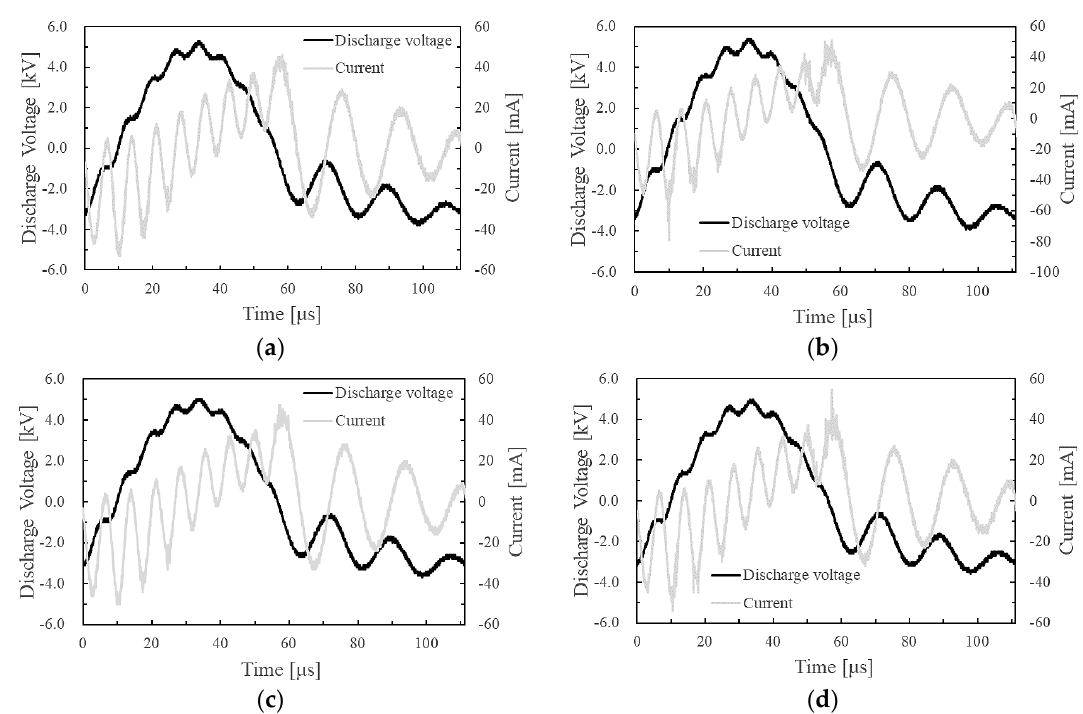
Figure 3. Discharge voltage and current waveforms at a self-sustaining discharge voltage V pp of 9.4 and 8.5 kV: ( a ) Ar / CF 4 gas mixture at V pp = 9.4 kV; ( b ) He / CF 4 gas mixture at V pp = 9.4 kV; ( c ) Ar / CF 4 gas mixture at V pp = 8.5 kV; ( d ) He / CF 4 gas mixture at V pp = 8.5 kV.